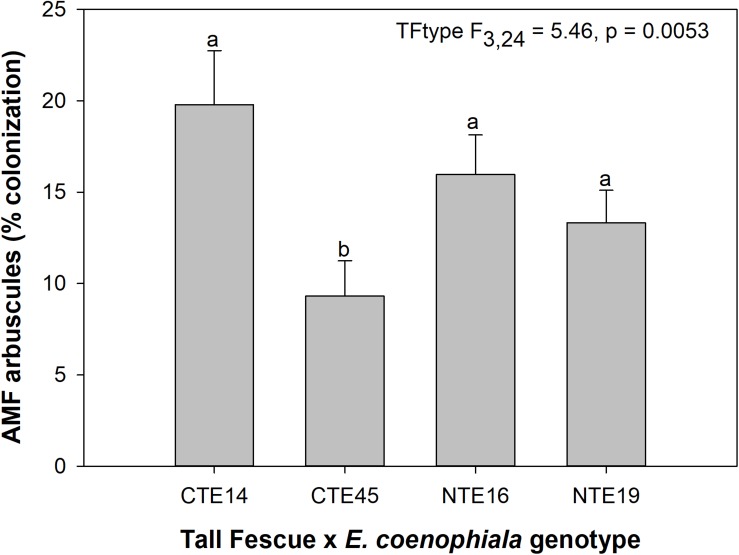
Main effect of tall fescue symbiotic genotype (TFtype) on arbuscule presence in tall fescue roots. Values are means ± 1 SE, and values with different letters are significantly different (α < 0.05).